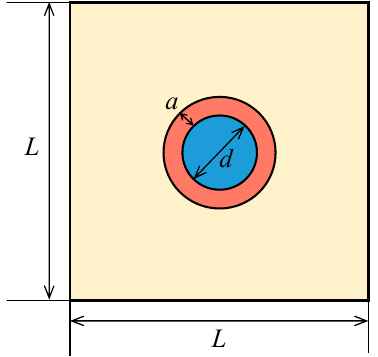
Figure 2. Coated vibrator model in the FEM simulations.